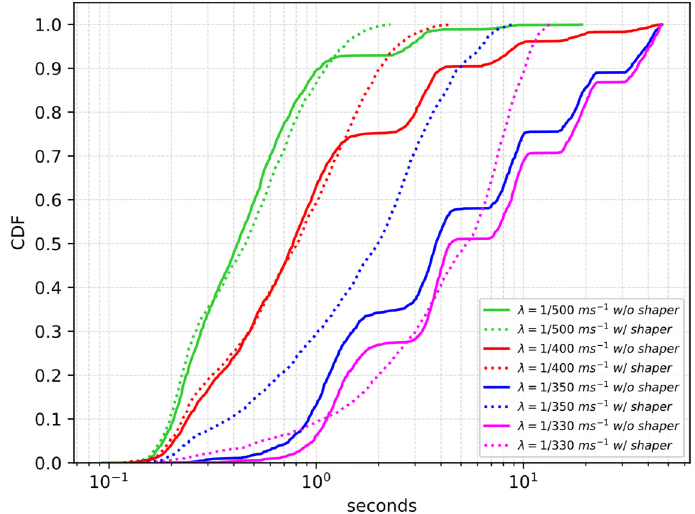
Figure 6. Service delay CDF w/ and w/o the request shaper.